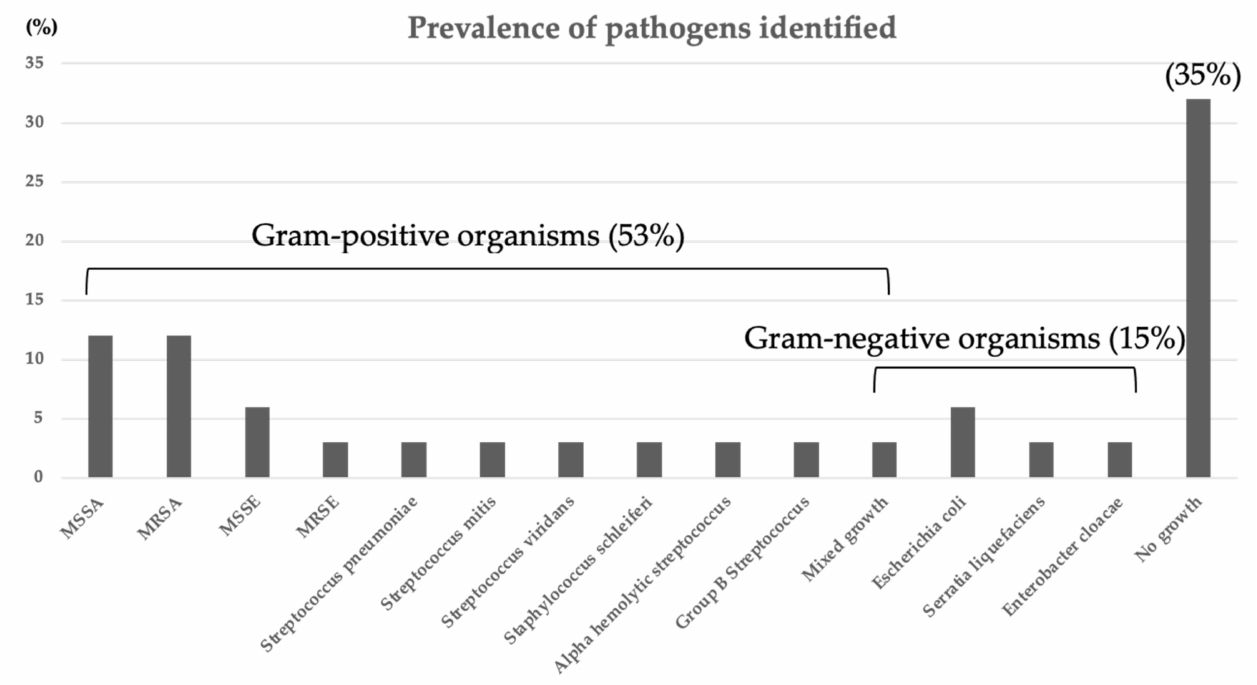
Figure 2. The causative organisms identified by blood culture, percutaneous image-guided needle biopsy, and surgical biopsy. An overall rate of bacteriological identification resulted in 65% (22 of 34 patients). The isolated organisms consisted most commonly of Gram-positive cocci at 81% (18 of 22 patients) such as Staphylococcus aureus / epidermidis with methicillin-sensitive (MSSA/MSSE (18%)) and -resistant strains (MRSA/MRSE